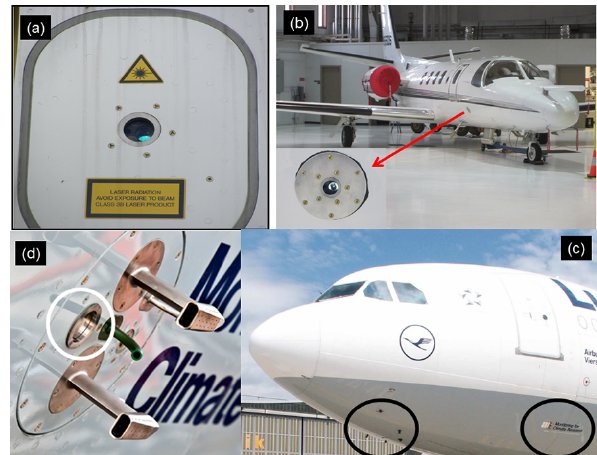
the scaling down in size and weight of cloud